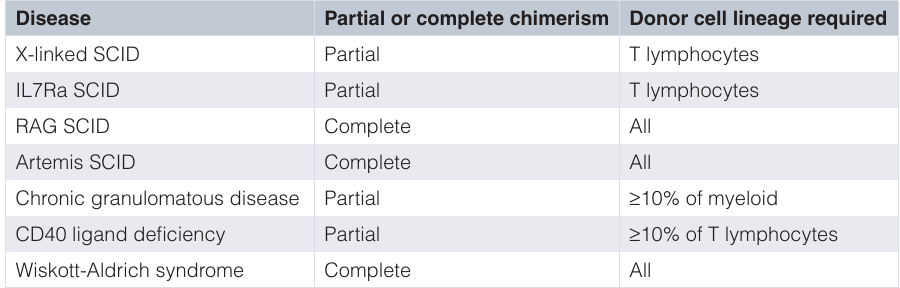
Table 1. Examples of primary immunodeficiencies for which complete or partial donor chimerism will achieve disease cure.